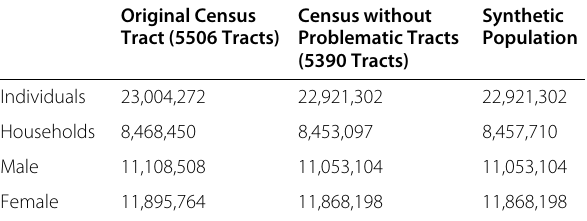
Table 3 Population counts based on multiple sources